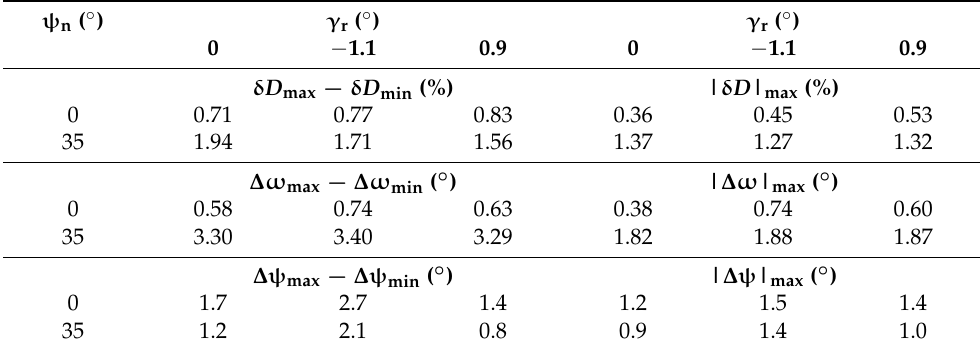
Table 6. Effect of the mutual tilt between the camera and the